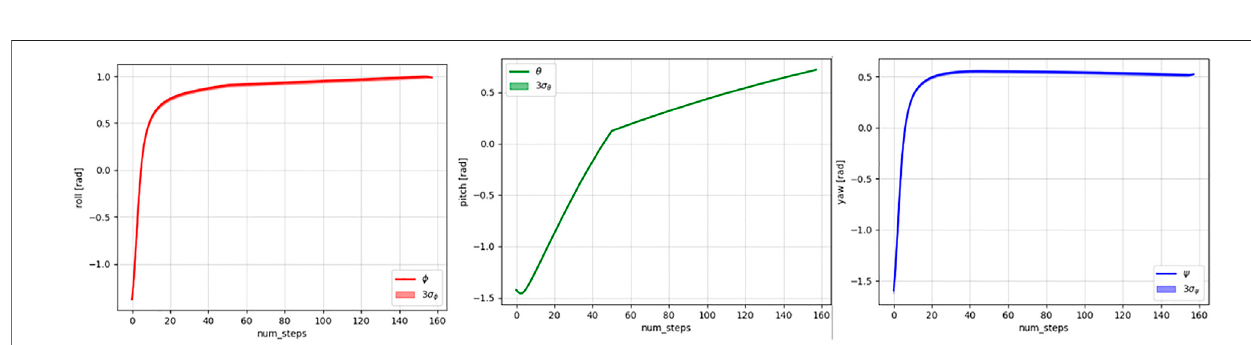
FIGURE 8 | Means and three standard deviations of the roll (left), pitch (middle), and yaw (right) values of the demonstrated trajectories.